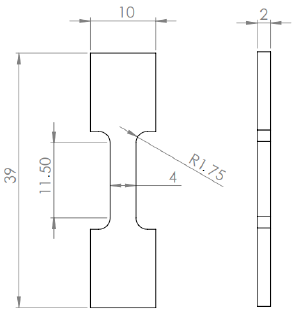
Figure 2. Tensile test specimen geometry. All dimensions are in mm.